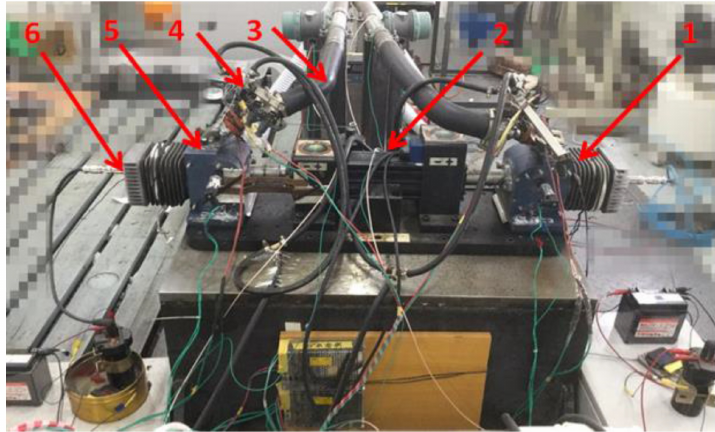
Figure 5. Free piston engine–generator setup with: (1) cylinder; (2) generator; (3) air intake system; (4) fuel injection system; (5) scavenging case; and (6) ignition system